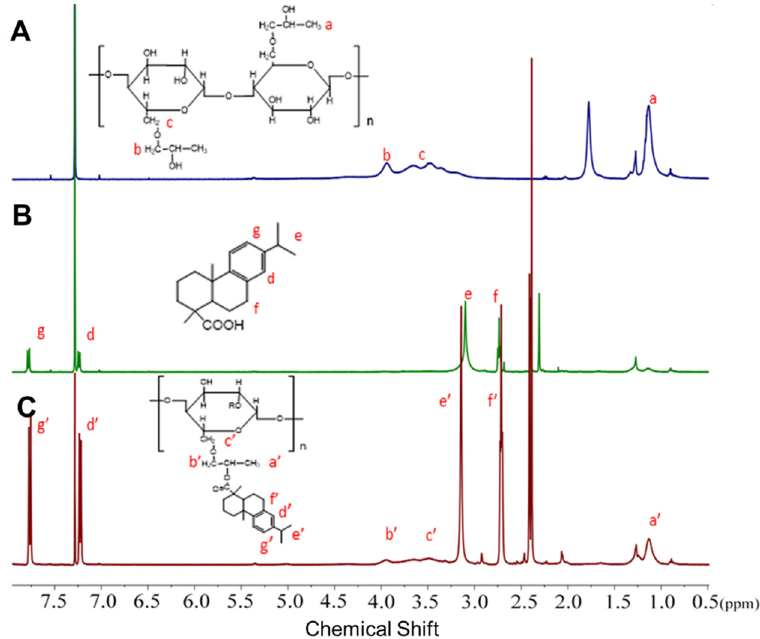
Table 2. HPC- g -AA characteristics with DS.